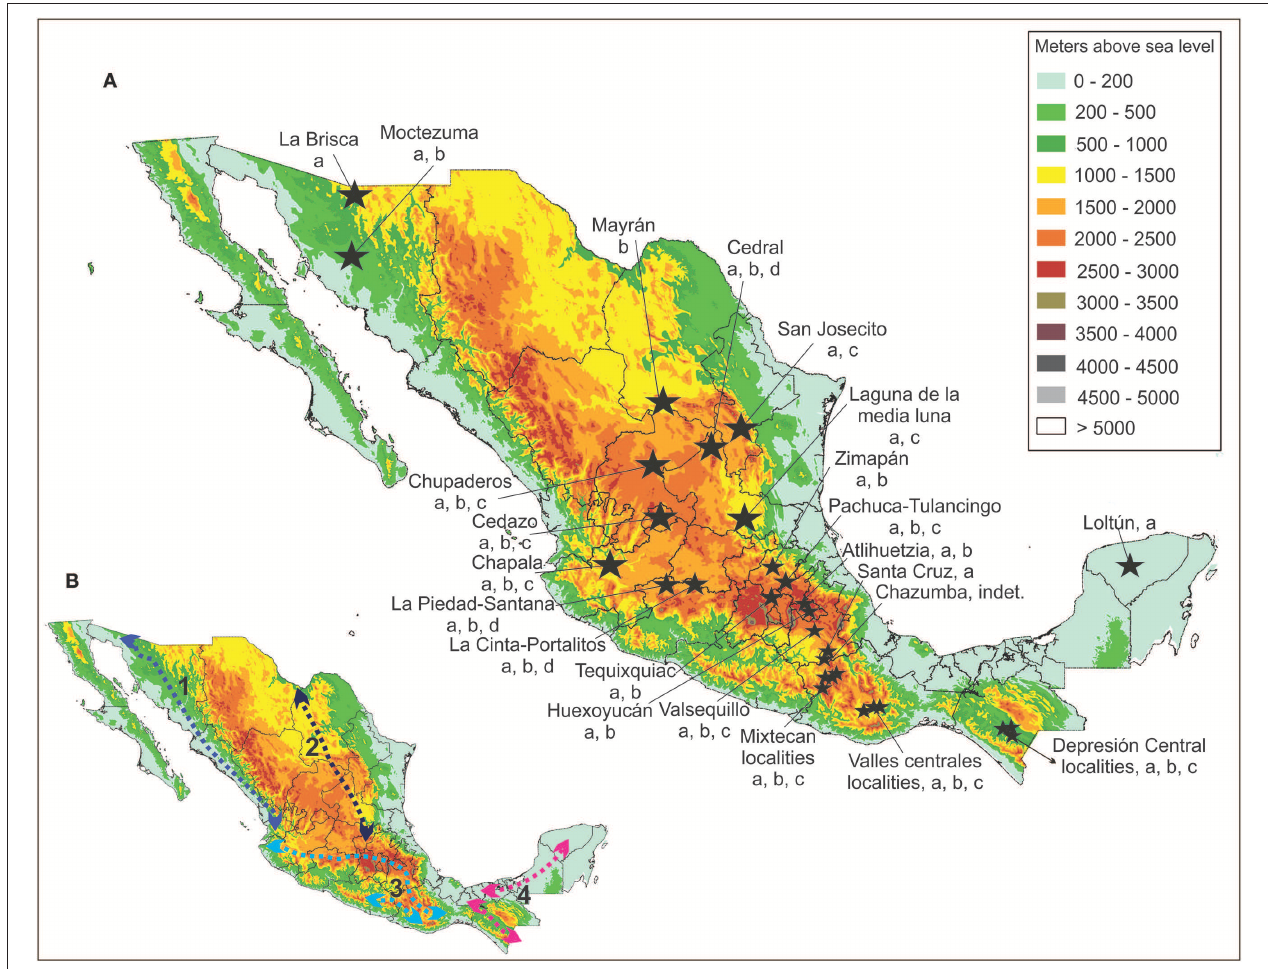
FIGURE 8 | (A) Main Late Pleistocene Mexican equid localities. a, Equus conversidens ; b, E. mexicanus ; c, Haringtonhippus francisci ; d, E. cedralensis . Data from Priego-Vargas et al. (2017). (B) Mexican biogeographic corridors used by Pleistocene equids. 1. Sonora, Central America Pacific lowlands; 2. Rocky Mountains, Sierra Madre Occidental; 3. Transvolcanic Belt, Sierra Madre del Sur; 4. Tamaulipas, Central America Gulf